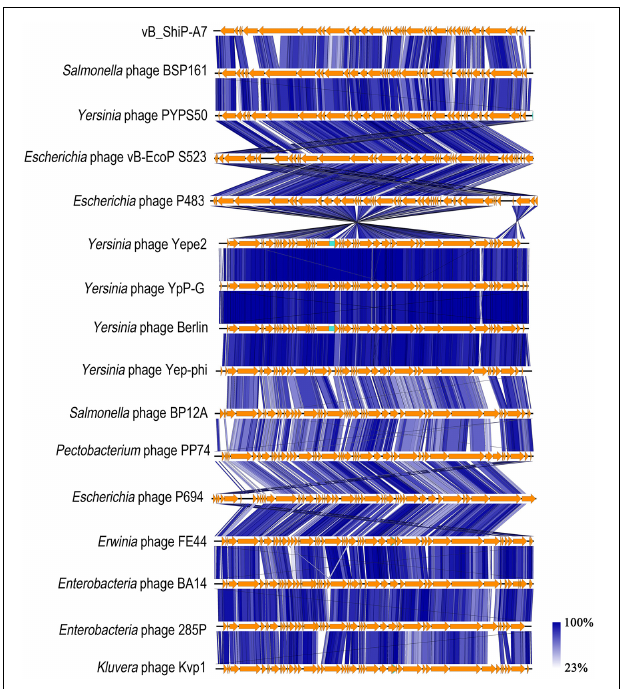
FIGURE 5 | Schematic genomic alignment of phage vB_ShiP-A7 with its related phages. Homologous ORFs or genes are present in brown, and amino acid identities of different proteins are indicated by different shades of